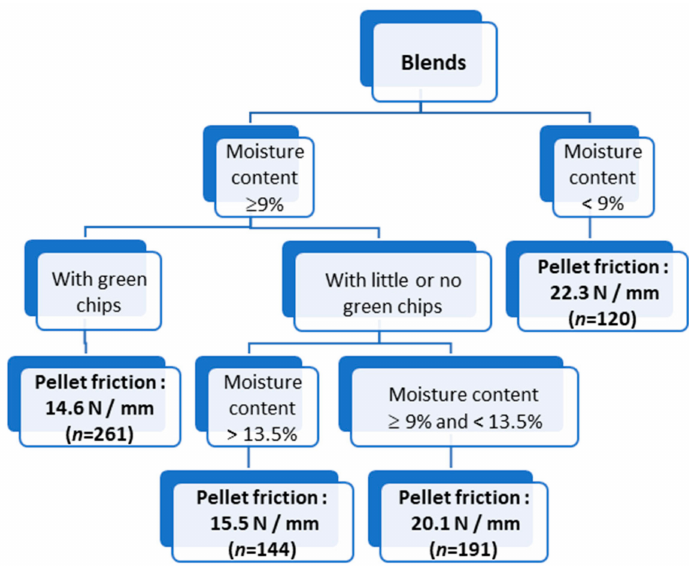
Figure 4. Regression tree of pellet friction, with averages and number of observations (in parentheses).